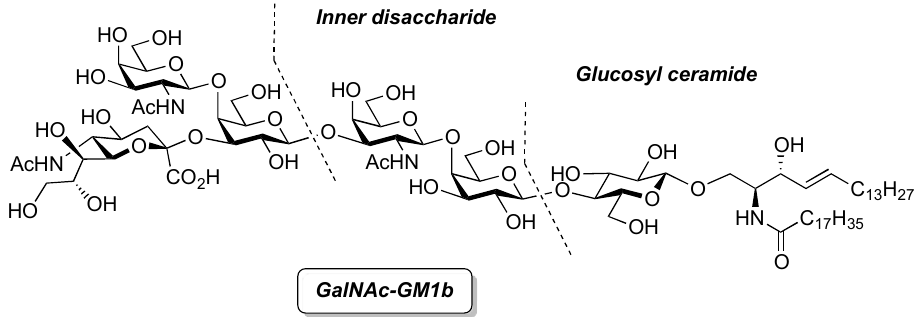
Figure 2. Structure of ganglioside GalNAc-GM1b and key disconnections for total